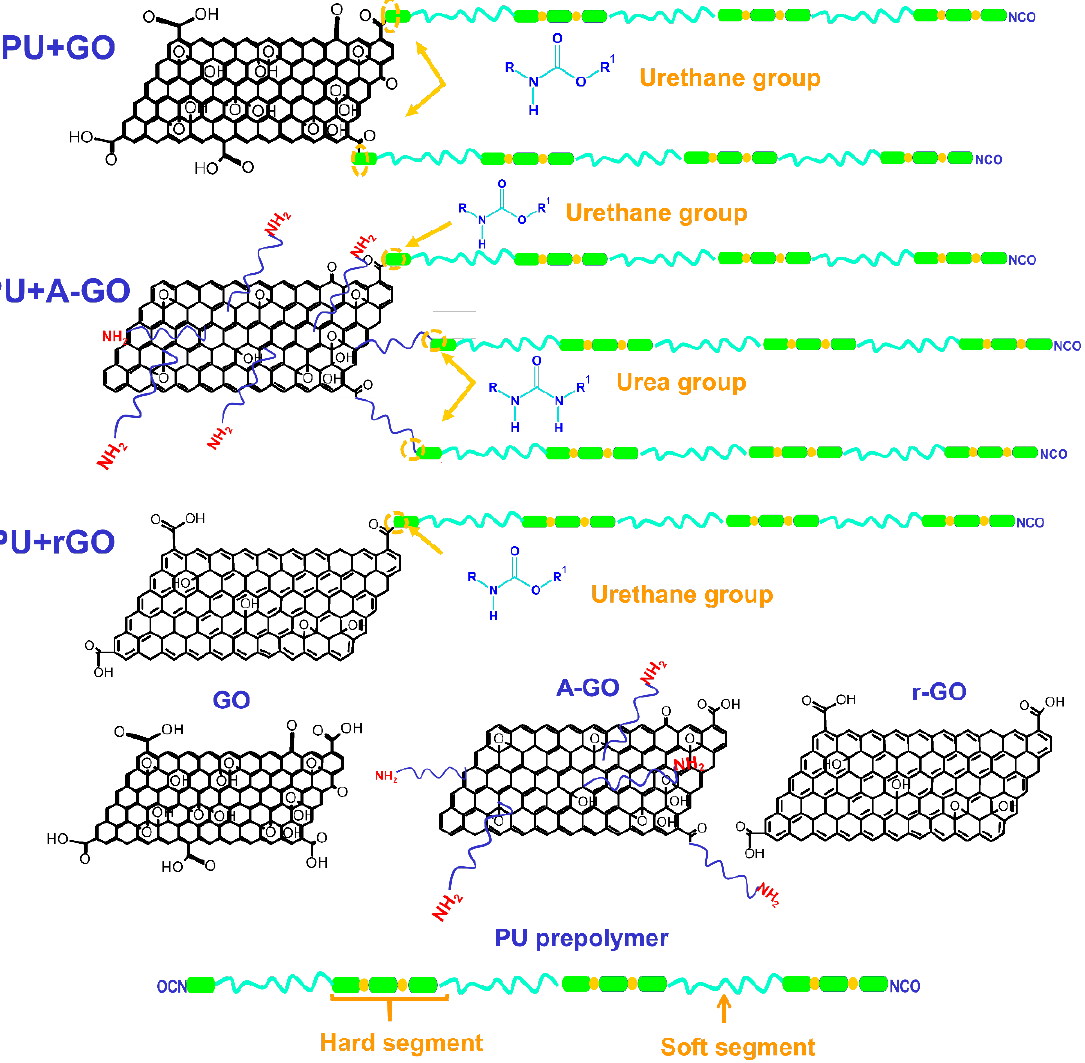
Figure 18. Scheme of the covalent linkages between the functional groups on the GO derivatives surfaces and the end NCO groups of the prepolymer produced during PUD synthesis.